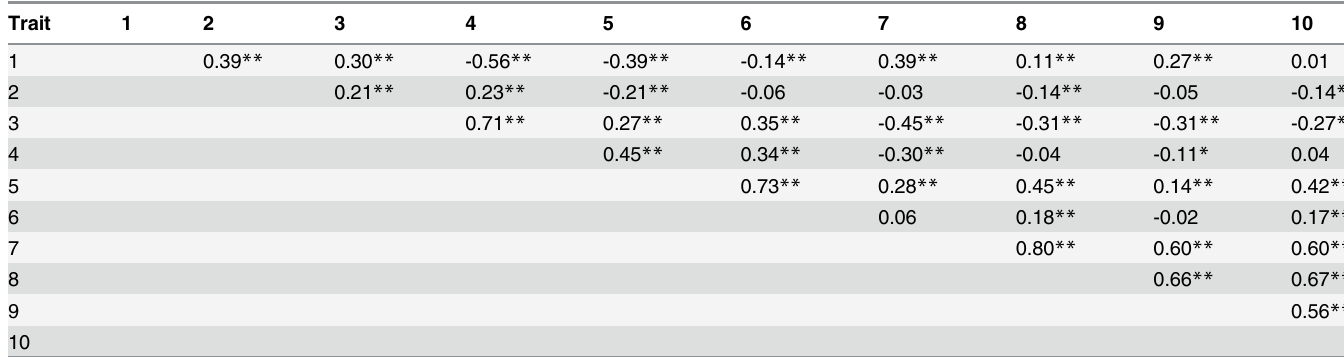
Table 2. Phenotypic Correlations Among Compounds.